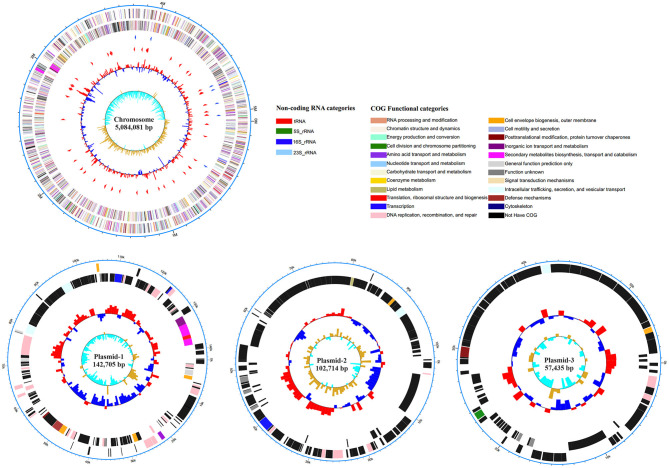
Circular representation of the chromosome and plasmids of strain BCE049 and related annotations. Maps were established using the software Circos v0.64 (http://circos.ca/). The key information pertains to the circular diagrams (outside to inside): the outermost rings show scales of the BCE049 chromosome and plasmids, where each division is 0.5 Mb and 10.0 kb, respectively; the second rings show the coding sequence (CDS) on the positive chains, and the different colors indicate the functional classification of different Clusters of Orthologous Group (COGs) of the CDS; the third rings show the CDS on the negative chains, and the different colors indicate the functional classification of different COGs of the CDS; the fourth ring shows non-coding genes (rRNA, tRNA, tmRNA); the innermost ring shows GC skew [(G – C)/(G + C)].